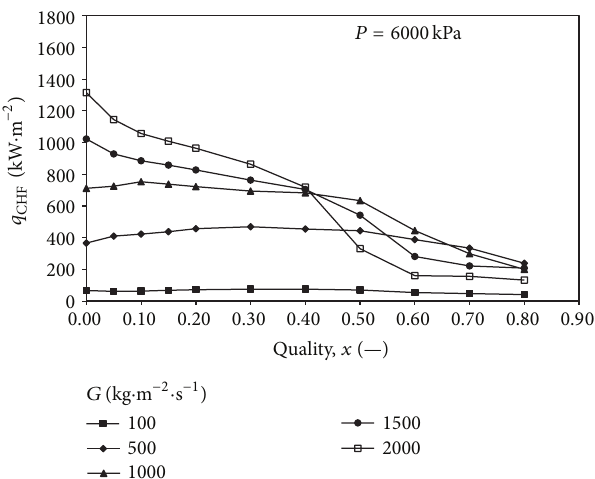
Figure 7: Effect of mass flux on CHF for horizontal flow of water in 67mm diameter tube as predicted by CHF-LUT.